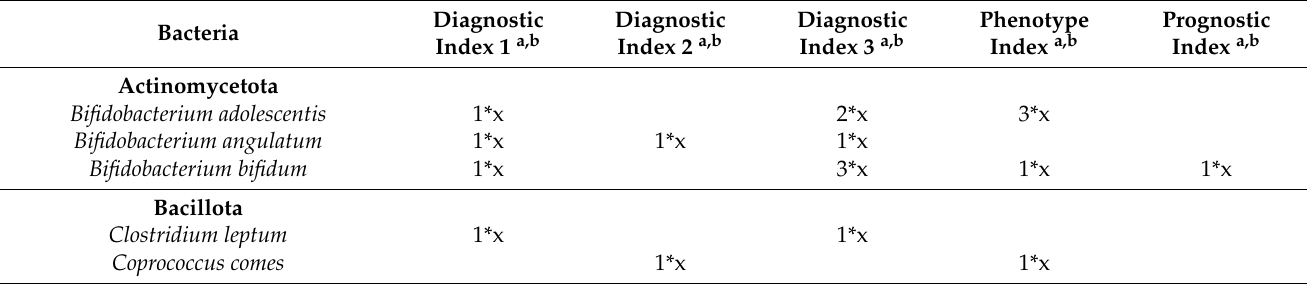
Table 4. Bacterial species included in the Diagnostic Indexes 1,2,3, the Phenotype Index and the Prognostic